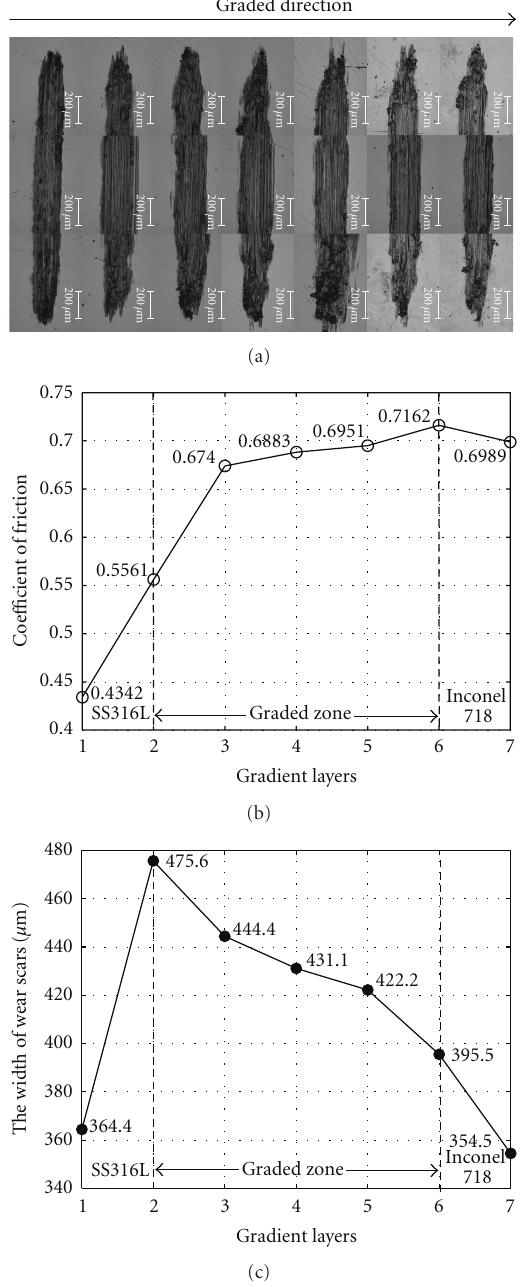
Figure 6: The wear properties of FGM2: (a) wear scars; (b) friction coe ffi cient; (c) width of wear